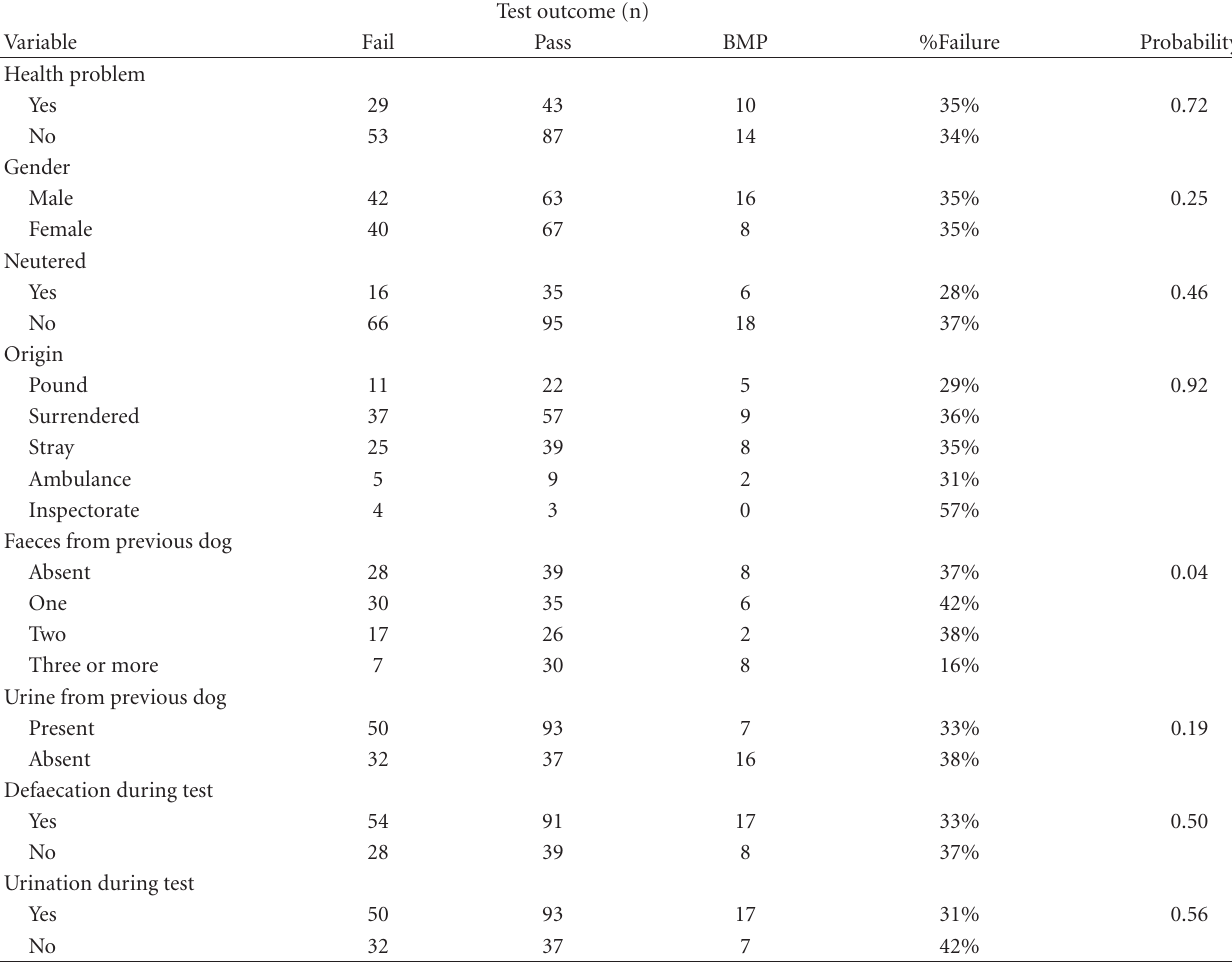
Table 3: The e ff ects of health problems, gender, neutered status, origin, faeces and urine from the previous dog test and defaecation and urination during the test on the number of dogs in the pass, fail and behaviour modification programme (BMP) categories of the first test.